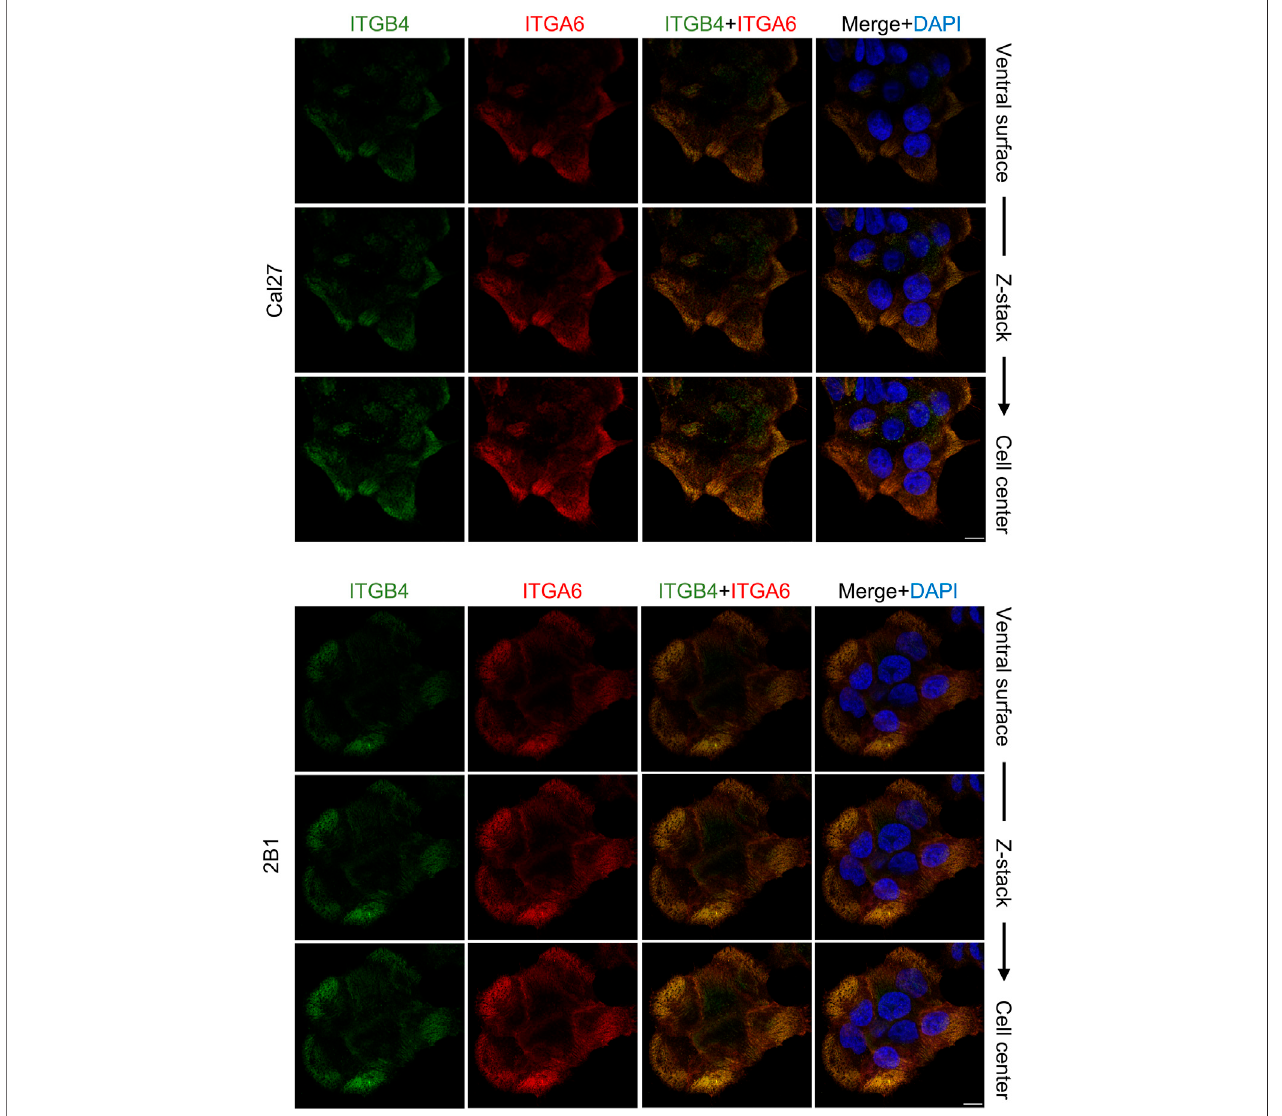
FIGURE 3 | Integrin subunits α 6 and β 4 co-localize in both Cal27 or 2B1 cells. Confocal z stack images of Cal27 and 2B1 cells. Forty-eight hours after seeding on coverslips, cells were fi xed, permeabilized, incubated with antibodies against integrin anti- β 4 (ITGB4) antibody followed by Alexa-Fluor 488-conjugated antibody (green) and integrin anti- α 6 (ITGA6) antibody followed by Alexa-Fluor 555-conjugated antibody (red). Nuclei were stained with DAPI (blue). Analysis was performed using TCS SP8 Leica. Scale bar (cid:2) 10 μ m.